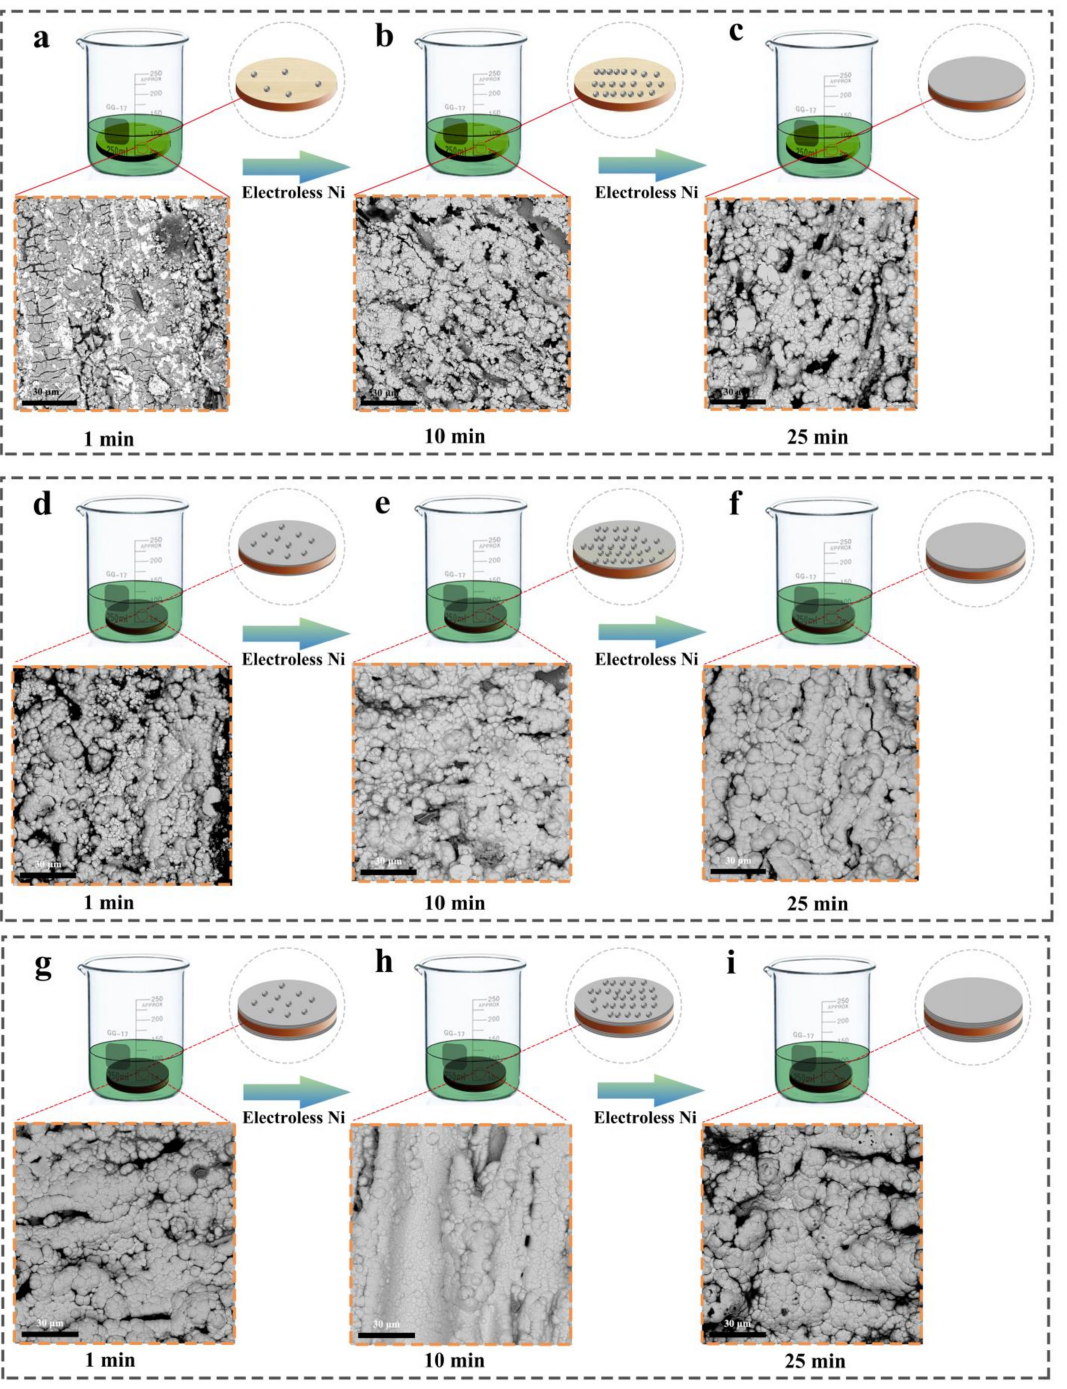
Figure 1. Schematic illustration and corresponding SEM images of the formation of Ni layer at different stages. (Images labeled from ( a – c ) is electroless Ni process schematics; image labeled from ( d – f ) is two electroless Ni process schematics; image labeled from ( g – i ) is three electroless Ni process